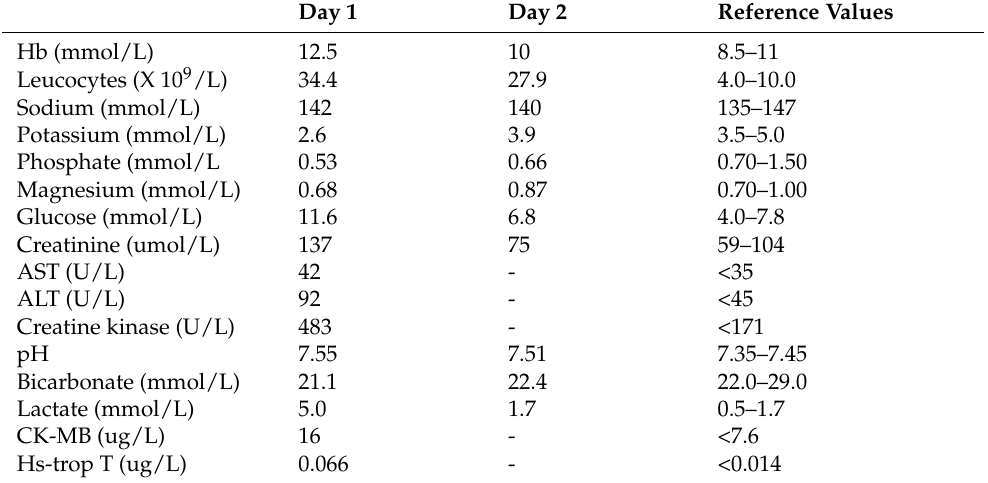
Table 1. Laboratory results (No indication for follow-up or previously